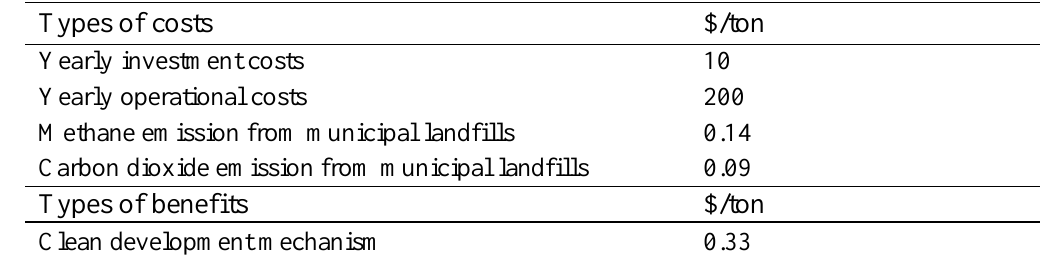
Table 4 .summary of costs and revenues of landfill ($/ton of MSW) BC Berlin